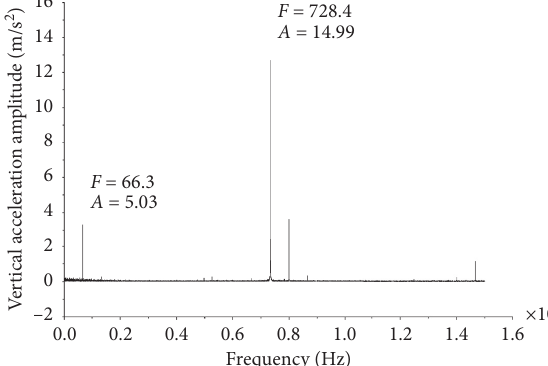
Figure 8: Vertical acceleration of the modified model.